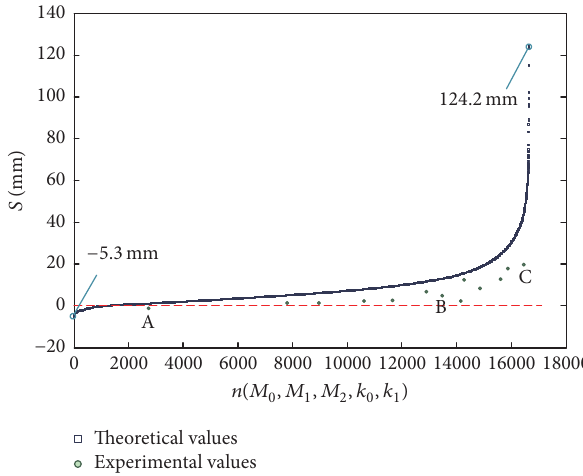
Figure 6: The displacement curve with every structure parameter: the relationship of S with n .